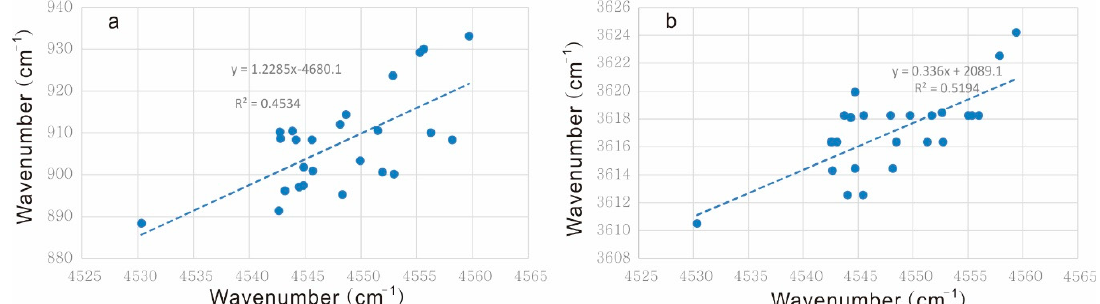
Figure 7. Linear correlation between NIR absorption bands and MIR (( a ) shows MIR bands near 907 cm − 1 , ( b ) shows MIR bands near 3625 cm − 1 ) absorption bands.